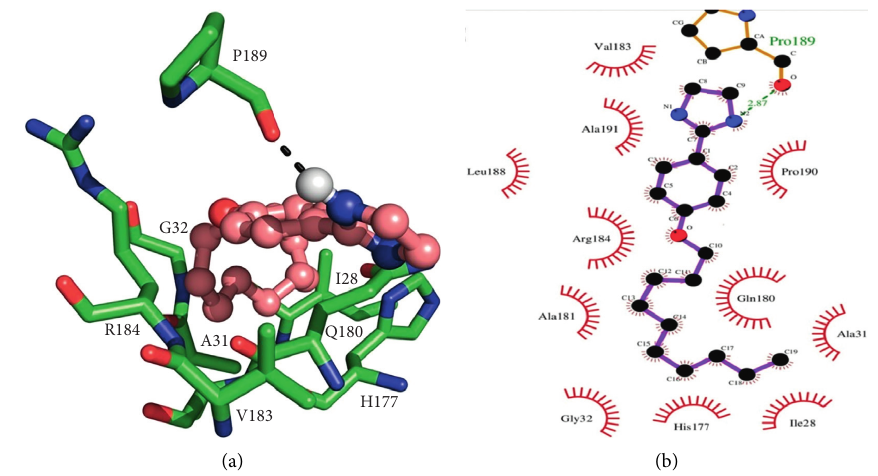
Figure 13: A 2D schematic diagram depicting the interactions between 15 and